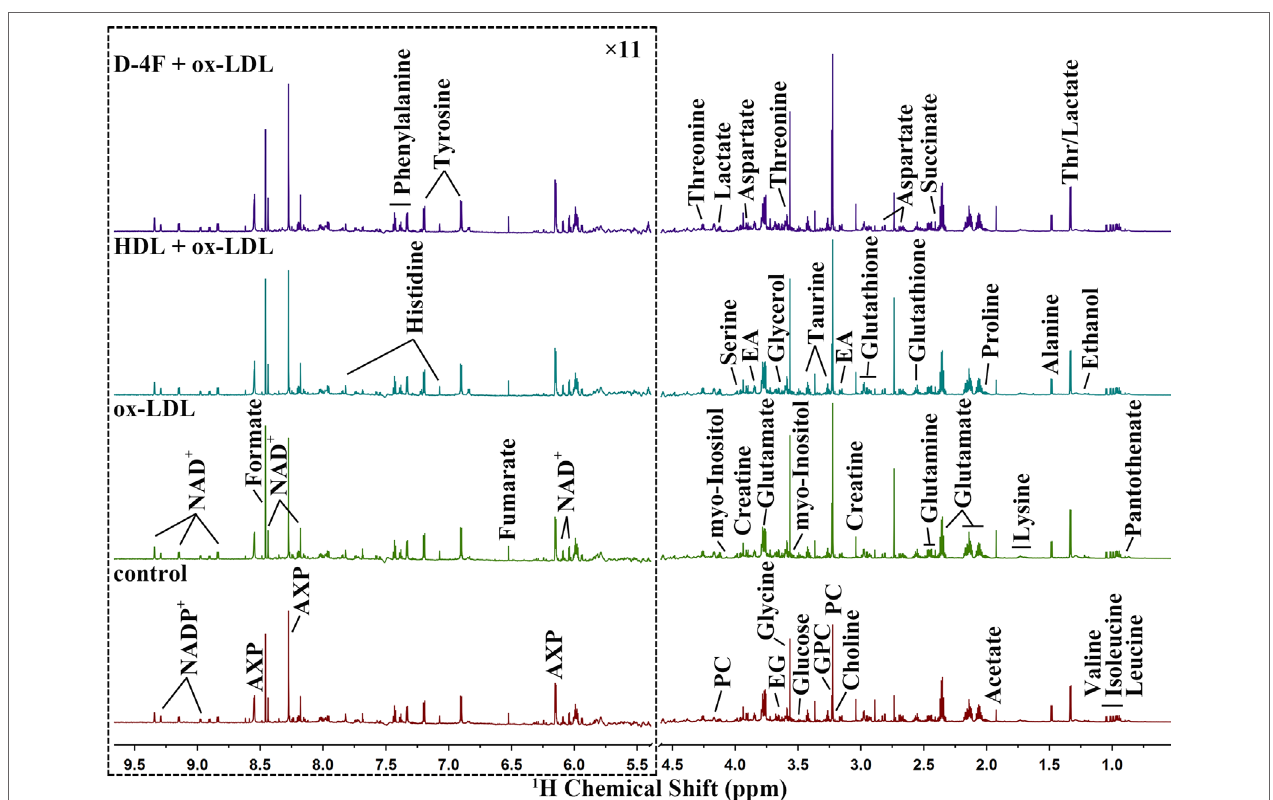
FIGURE 3 | Average 850 MHz 1D 1 H NMR spectra recorded on aqueous extracts derived from endothelial cells. The vertical scales were kept constant in all the 1 H spectra. The water region (4.5–5.5 ppm) was removed. The region of 5.5–9.5 ppm (in the dashed box) was magnified 11 times compared with the corresponding region of 0.5 to 4.5 ppm for the purpose of